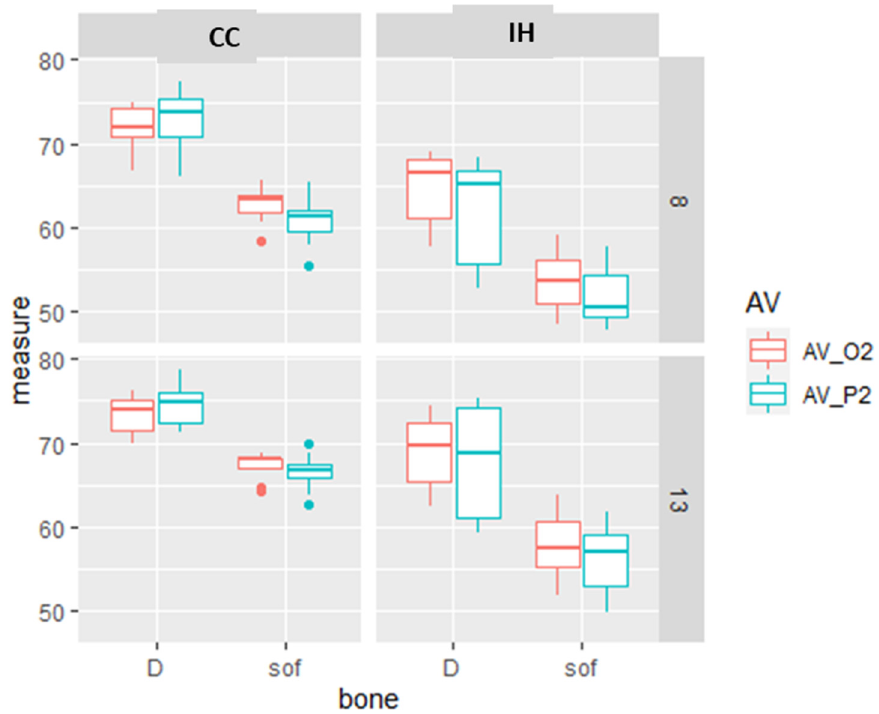
Figure 2. Box and whiskers plot of the RFA measurements of Osstell (O2) and Penguin (P2) in the D = dense and sof = soft bone type, in CC and IH implant design and 8 or 13 mm implant length. The box represents the interquartile range and the median, and the whiskers represent the SD. There are some values that are outliers.